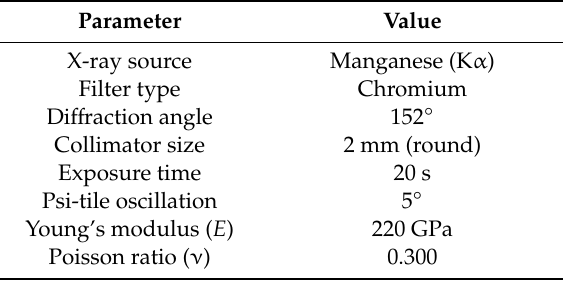
Table 1. Key parameters of residual stress